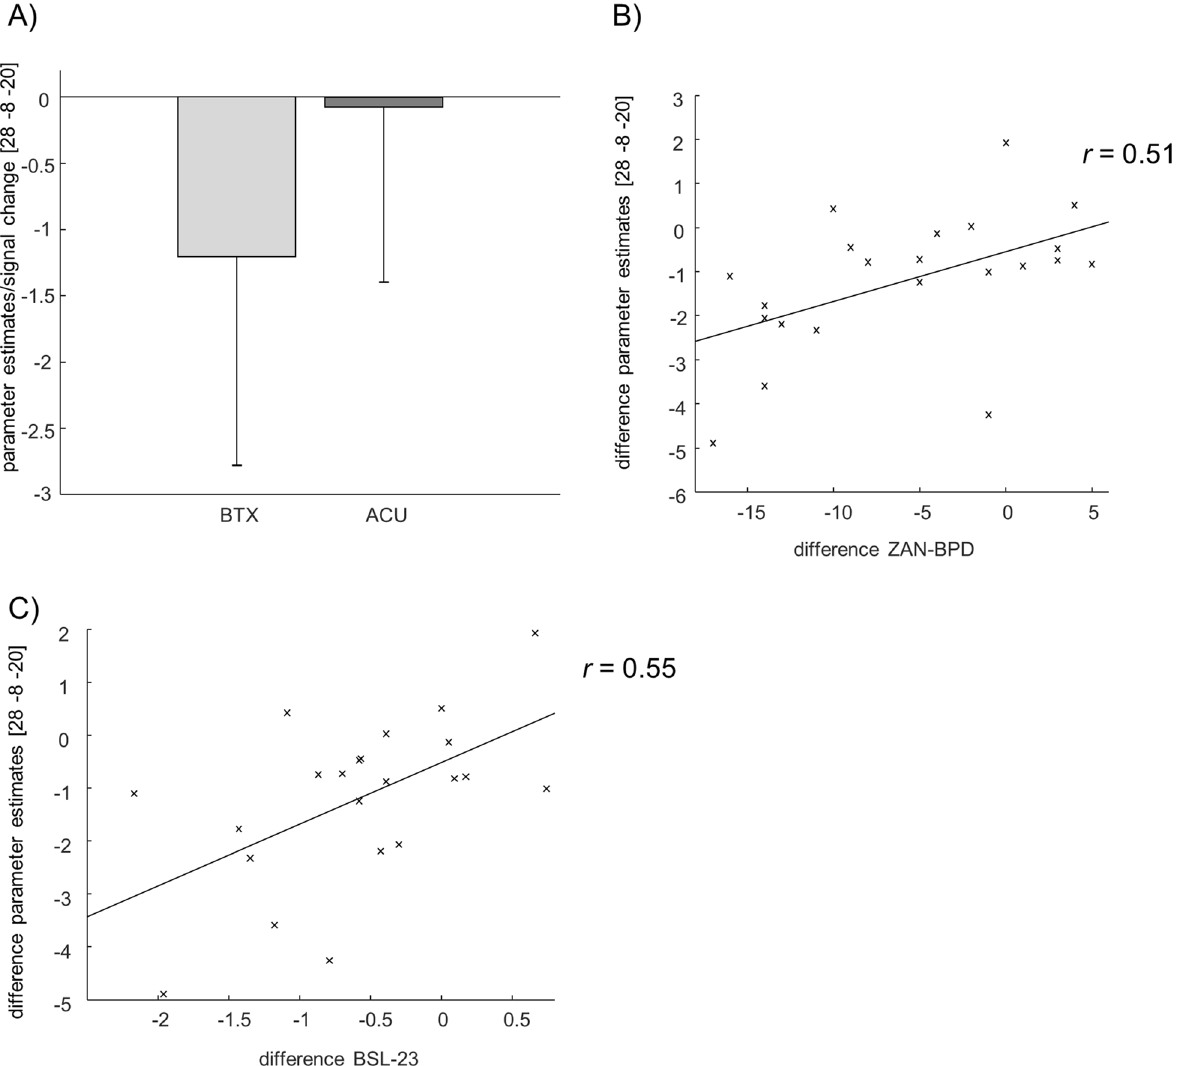
Figure 2. Brain activation of the amygdala at angry pictures: ( A ) Change of parameter estimates in the right amygdala for the BTX and ACU group. ( B ) Correlation between the difference of the parameter estimates in the amygdala and the difference of ZAN-BPD for BTX. ( C ) Correlation between the difference of the parameter estimates in the amygdala and the difference of BSL-23 for